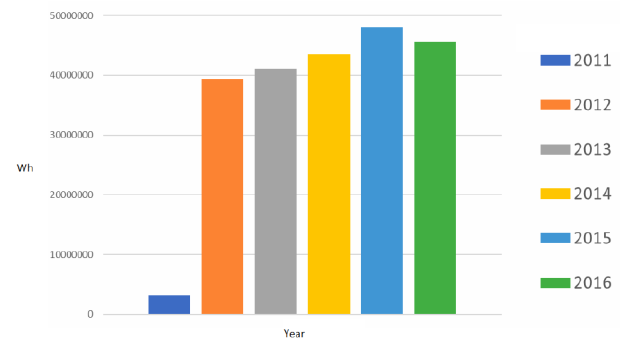
Figure 5. Energy production over the years.